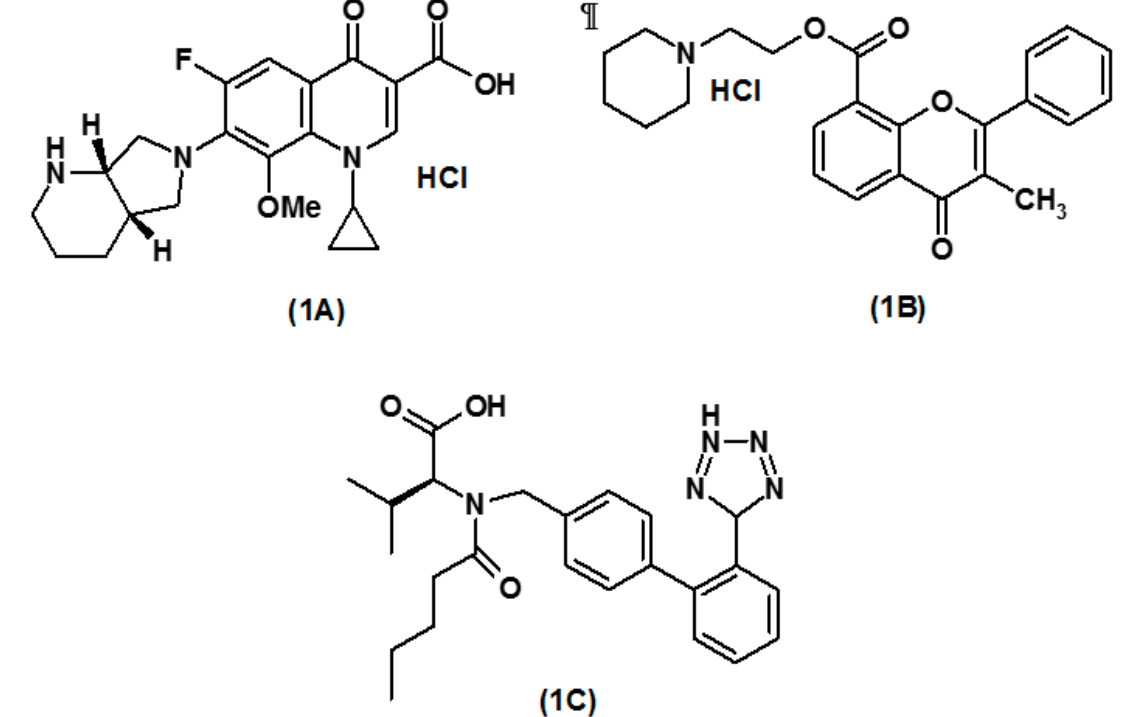
Figure 1. Chemical structures of moxifloxacin HCl [1A], Flavoxate HCl [1B] and valsartan [1C].